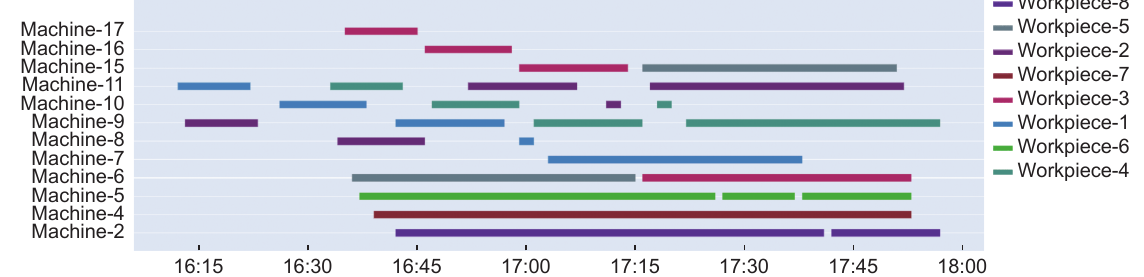
Fig. 5 Distribution-1, 8 workpieces scheduling gantt chart (Dec 19,